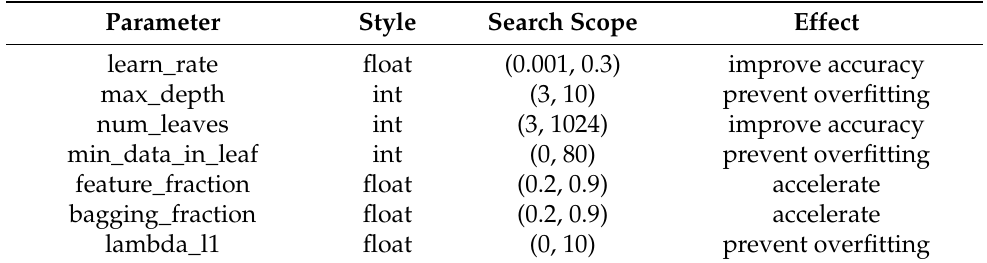
Table 3. The LightGBM hyperparameters selected in this article and their